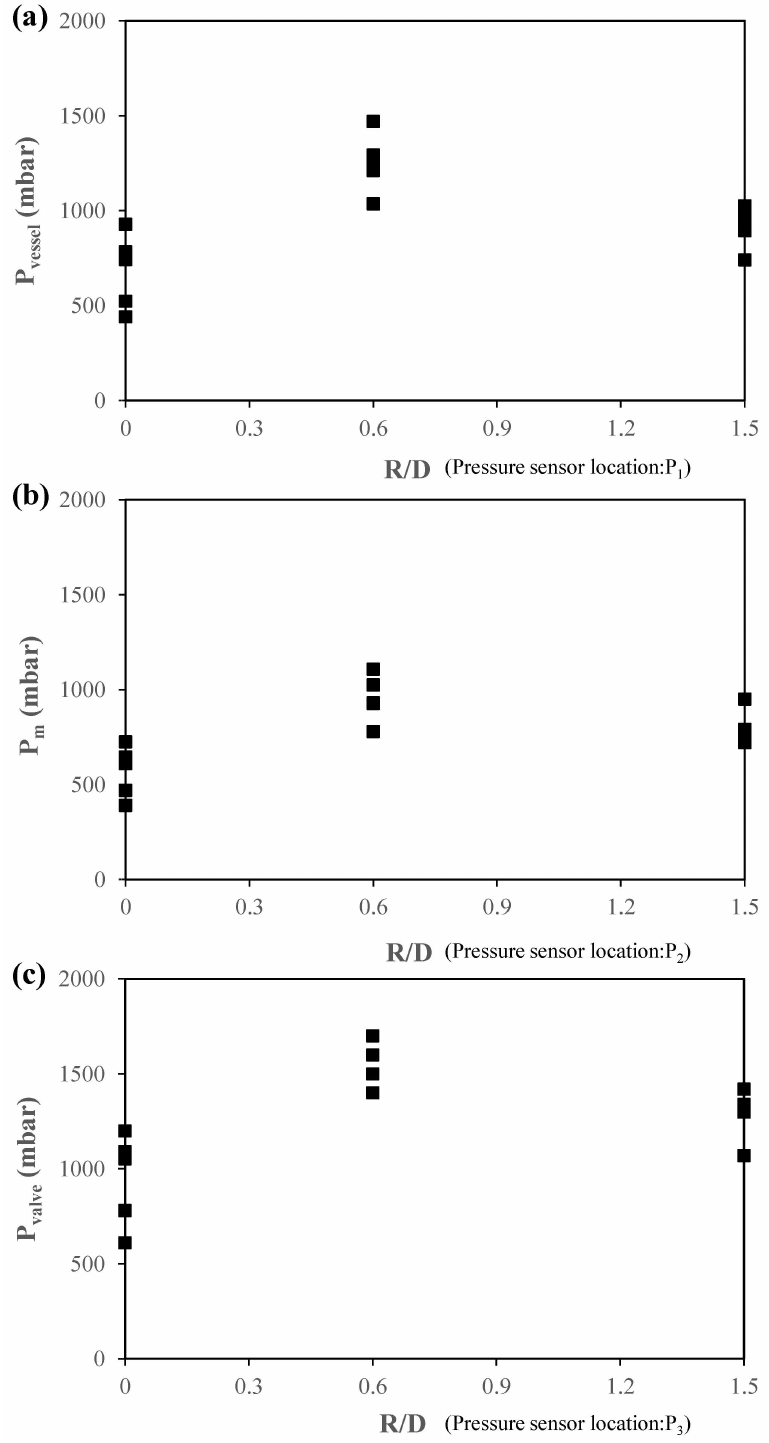
Figure 8. Influence of R/D ratio on pressure for aluminium dust explosions: ( a ) Vessel pressure (P 1 ), ( b ) pressure in the middle of duct (P 2 ), ( c ) valve pressure (P 3